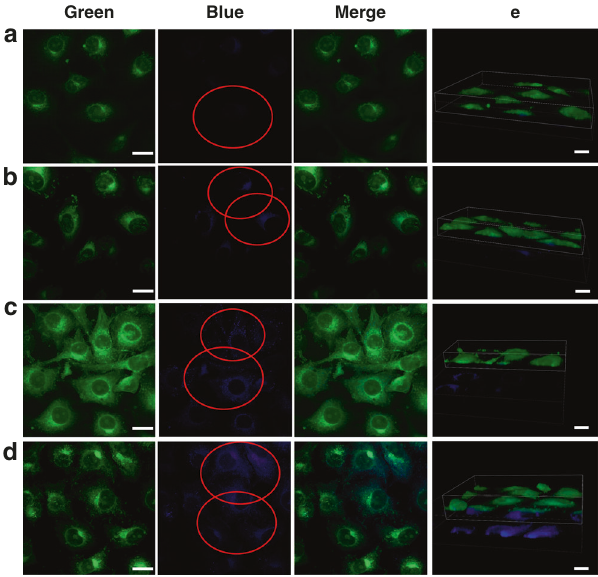
Fig. 5 Confocal laser scanning microscopy images of the nanomotors. The cellular uptake of HLA 10 nanomotor by HUVECs under different conditions: a HUVECs + HLA 10 nanomotor, b HUVECs + 0.002% H 2 O 2 + HLA 10 nanomotor, c HUVECs + NOS + HLA 10 nanomotor, d HUVECs + NOS + 0.002% H + HLA 2 O 2 10 nanomotor, and e a snapshot of a 3D rendered Movie (Supplementary Movie 6) made from a stack of confocal images. (Blue: nanomotors; Green: cell membrane) (Scale bar: 20 μ